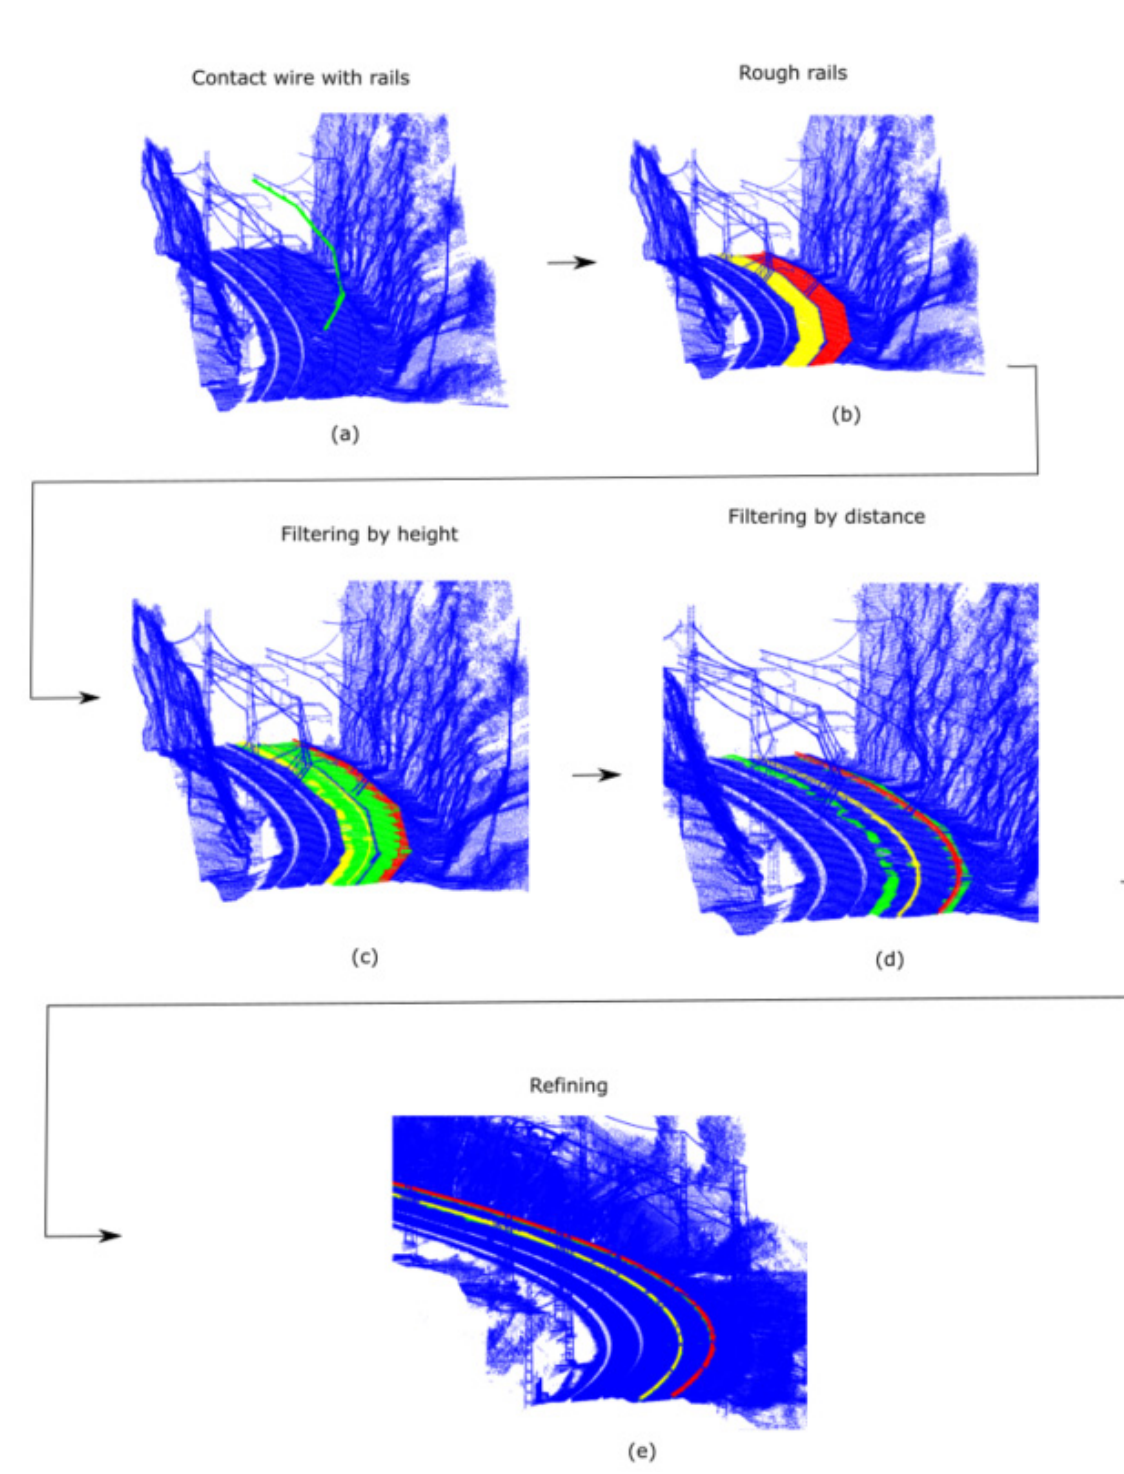
Figure 13. Rail segmentation workflow: ( a ) contact wire coloured in green corresponding to the rails under study; ( b ) rails and its surrender. Left rail coloured in yellow and right rail in red; ( c ) rail filtered by height. Rough rails coloured in green, left rail coloured in yellow, and right rail in red; ( d ) rails filtered by the distance between them. Starting rails coloured in green, left rail coloured in yellow, and right rail in red; ( e ) rails refined in C i . Starting rails coloured in green, left rail coloured in yellow, and right rail in red.